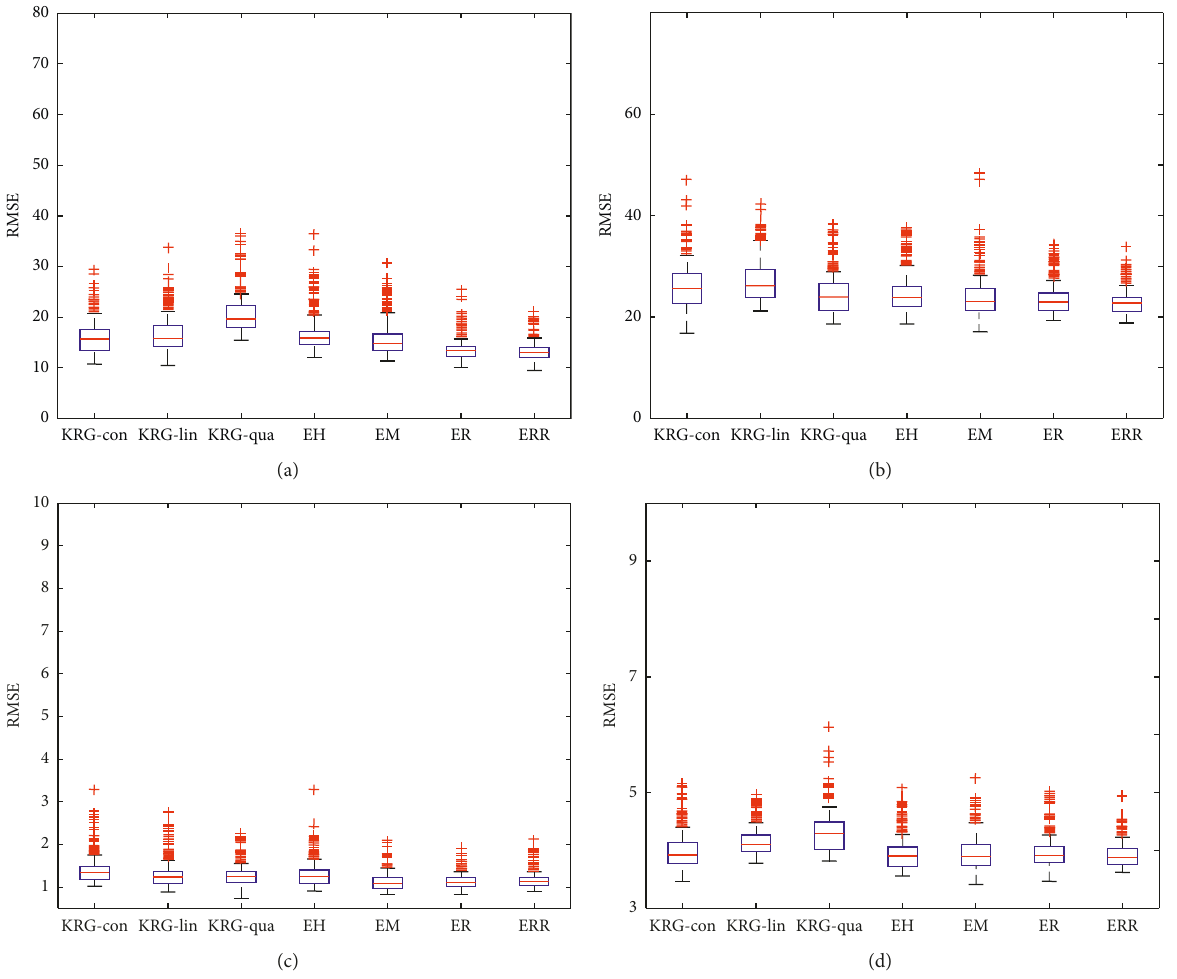
Figure 5: RMSE for different surrogate models. (a) Numerical Example 1. (b) Numerical Example 2. (c) Numerical Example 3. (d) Numerical Example 4. Table 4: The mean and the coefficient of variation ( ψ ) of RMSE errors using different metamodels for different problems. Numerical Example